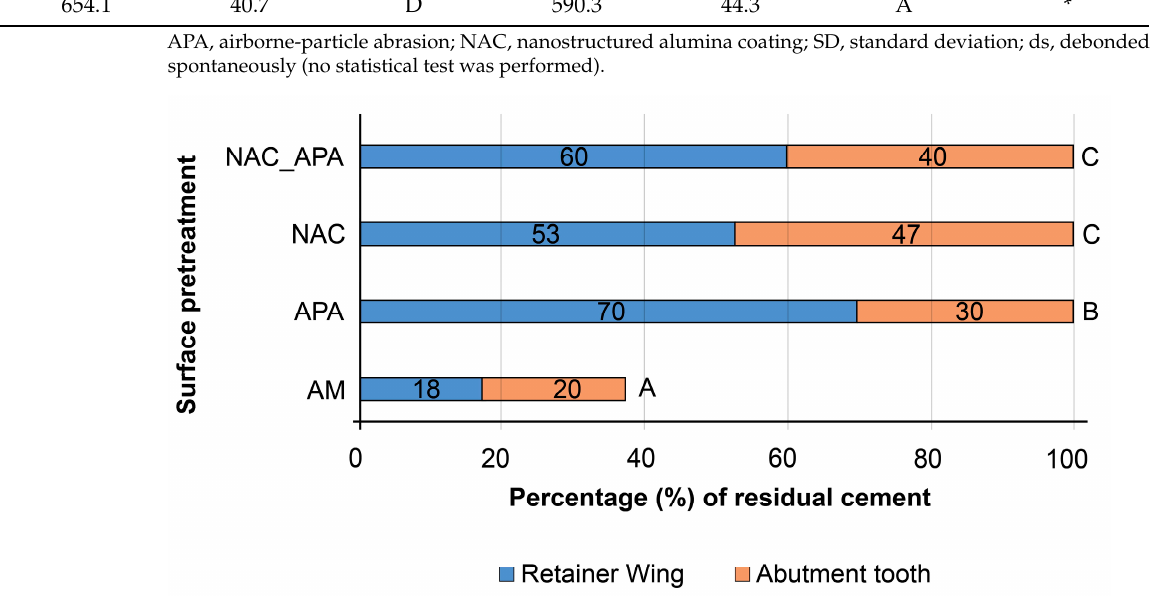
Figure 7. SEM micrographs of representative specimens for each experimental group after aging. ( a ) Low magni fi cation (original magni fi cation ×10) of debonded AM retainer wing ( fi gure inset), showing predominant adhesive failure. Higher magni fi cation (original magni fi cation ×1000)